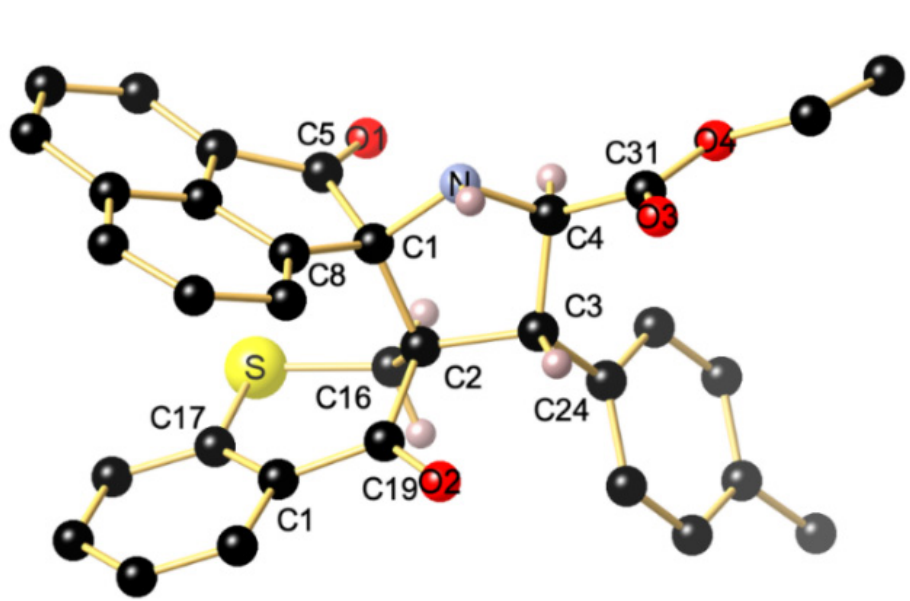
Figure 5. Ball and sticks presentation of the molecular structure of 4e recorded at 100 K. Only stereochemically relevant H atoms are shown.